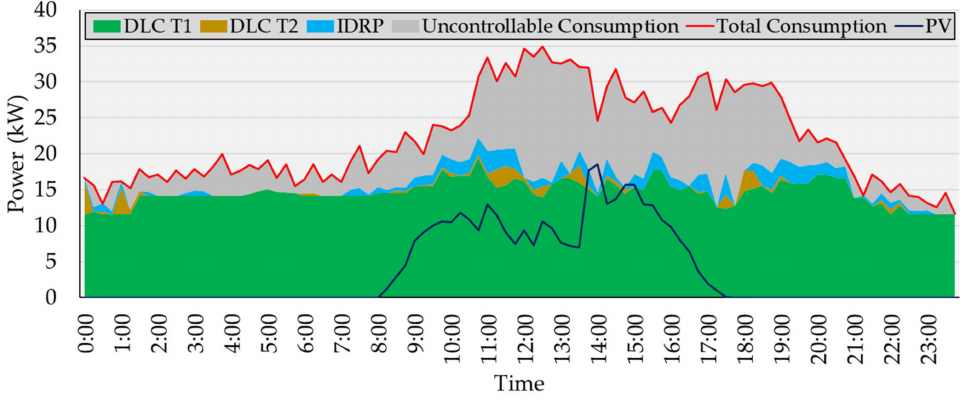
Figure 7. Aggregator consumption profile and stacked available DR capacities.